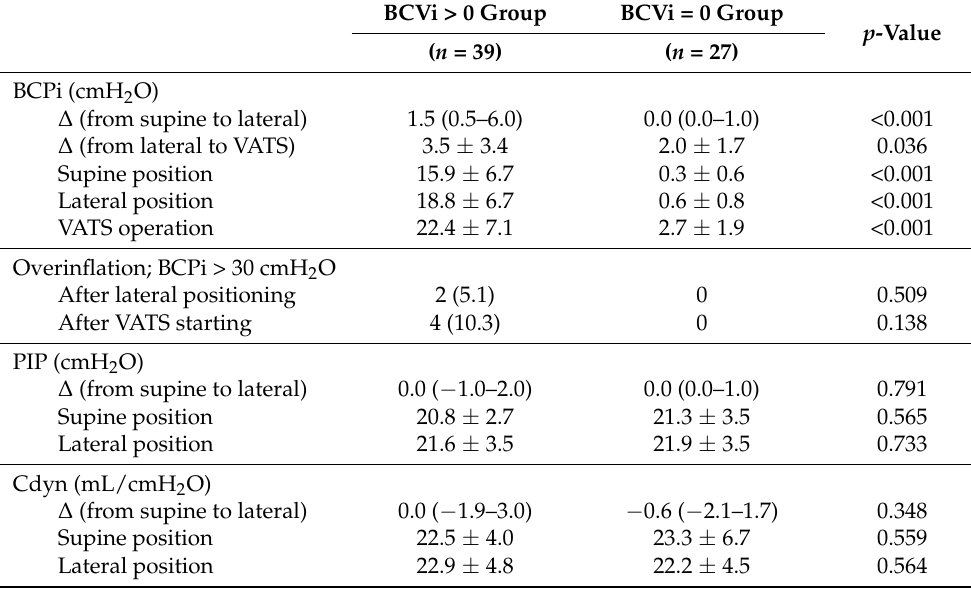
Table 4. Outcomes of bronchial cuff pressure and ventilatory